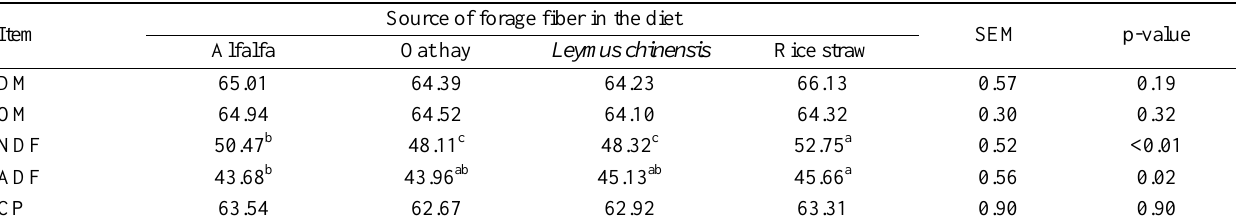
Table 4. Effects of alfalfa hay, oat hay, Leymus chinensis , and rice straw as dietary forage sources on apparent total tract digestibility of nutrients